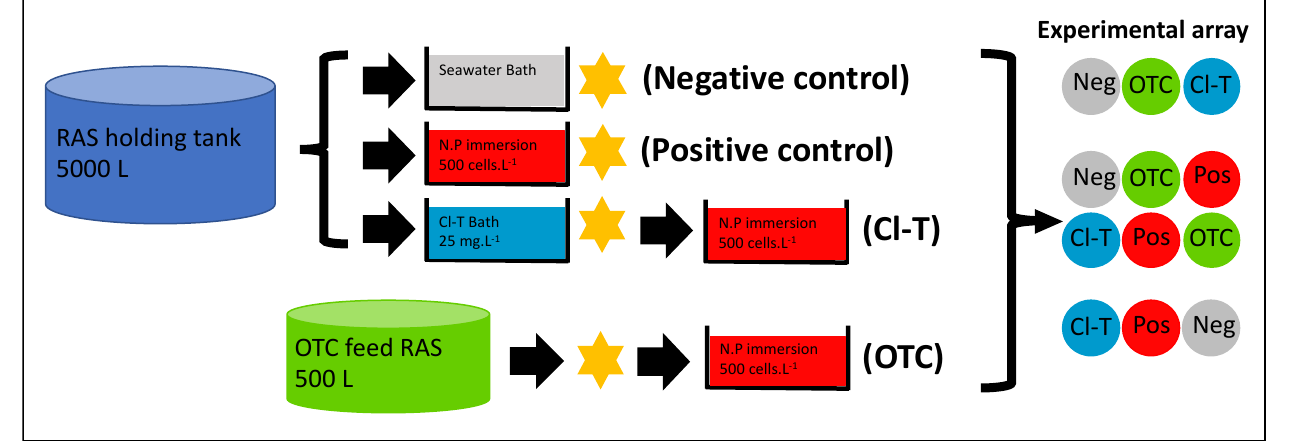
Figure 1. Flow diagram of experimental treatment preparation used in this study, showing treatment or challenge steps prior to stocking into experimental array (each treatment group was replicated three times). Star shape depicts when initial (Time 0) gill mucus sampling of 5 fish per tank (15 fish per treatment group) was